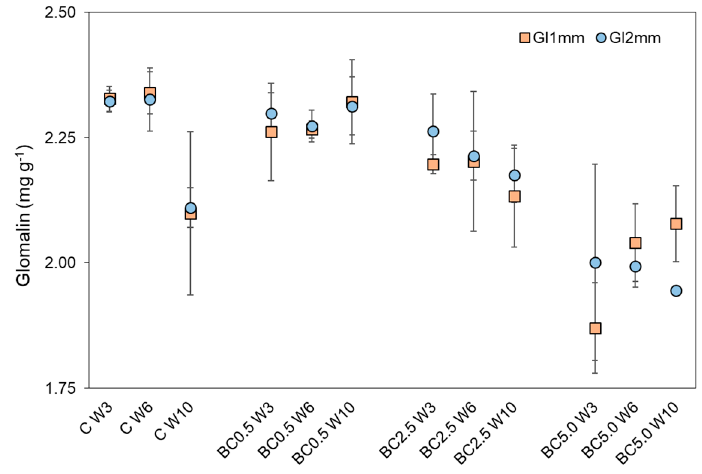
Figure 6. Glomalin (easily-extractable glomalin-related soil protein, EEG-GRSP) production for the different treatments over time. C, BC0.5, BC2.5, and BC5.0 represent control, 0.5%, 2.5%, and 5.0% biochar amended soil, respectively. W represents the number of weeks during sampling periods.